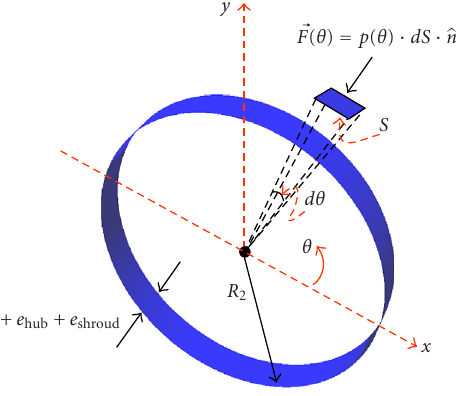
Figure 22: Radial force integration around impeller periphery.